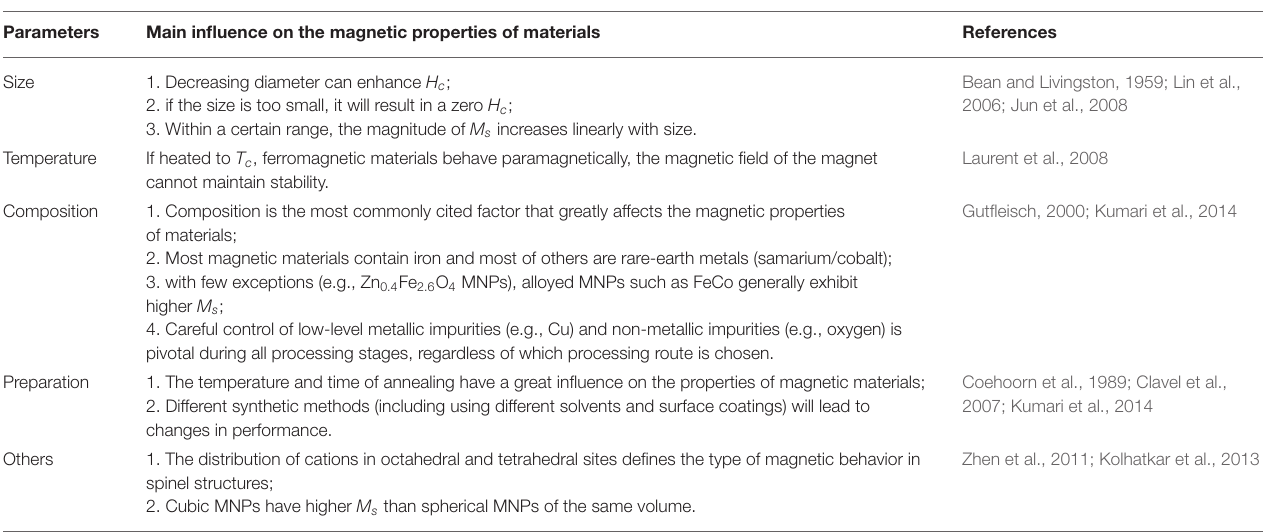
TABLE 3 | Parameters influencing the magnetic properties of